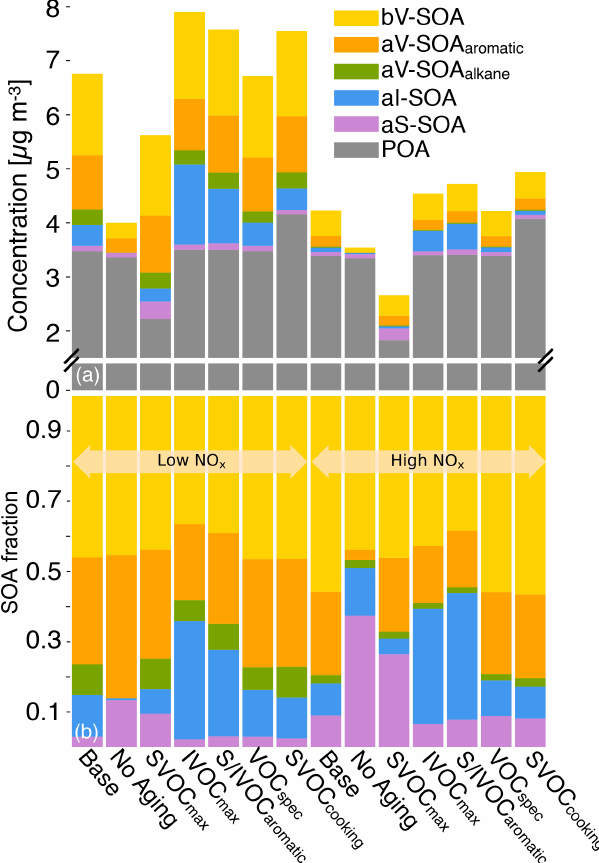
Figure 5. The 14-day-averaged model predictions of POA and SOA mass concentrations and precursor contributions from the sensitiv- ity simulations. Panel (a) shows absolute concentrations and panel (b) shows precursor contributions. Model predictions from the low- and high-NO x simulations are shown separately. Simulation legend: Base – Base case; No Aging – only models first generation chem- istry in the SOM; SVOC max – all POA treated as semi-volatile; IVOC max – all combustion sources assumed to have 20% IVOC emissions and a C 15 SOA yield; S-IVOC aromatic – SVOCs and IVOCs modeled as high-yield aromatic compounds; VOC spec – mobile source emissions profiles based on May et al. (2014); SVOC cooking – POA volatility distribution for food cooking sources based on the measurements of Louvaris et al. (2017). All simula- tions besides SVOC cooking assumed food cooking POA to have the same volatility as biomass burning POA. More details about these simulation inputs can be found in Sect.